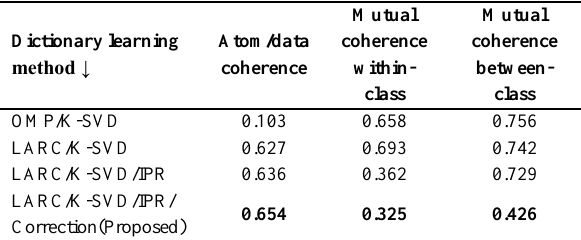
Table 11. The coherence parameter values for different dictionary learning methods.